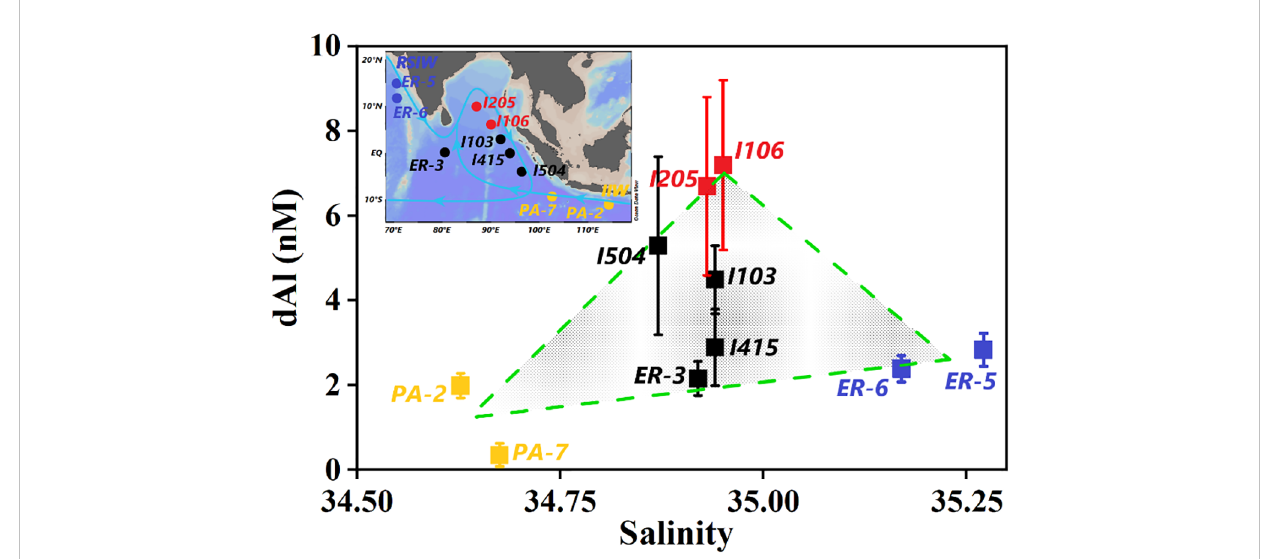
FIGURE 9 dAl variation with salinity for s 0 within 27.1 – 27.6 kg/m 3 from stations in this study. ER-3, ER-5, and ER-6 from Thi Dieu Vu and Sohrin (2013) and PA- 2 and PA-7 from Obata et al. (2004). The error bar means the range of dAl concentration. The inset map shows the locations of stations ahead, and the light blue line represents intermediate water ( s 0 within 27.1 – 27.6 kg/m 3 ) circulation pattern in the northeastern IO (adapted from You, 1998). dAl, dissolved aluminum; BoB, Bay of Bengal.